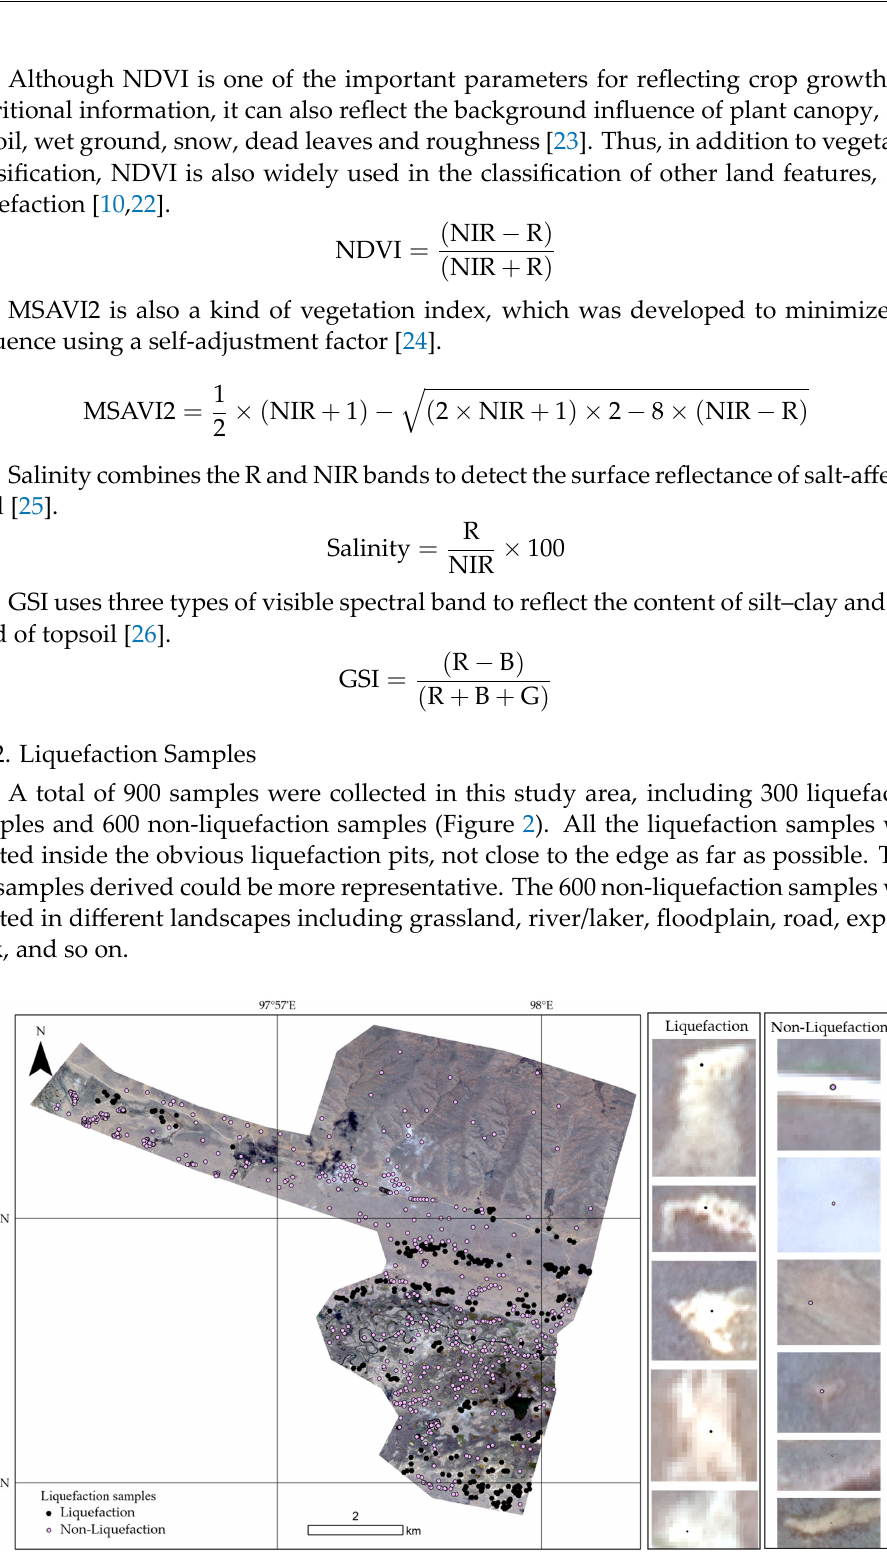
Figure 2. The spatial distribution of samples and some location details of the non- liquefaction/liquefaction